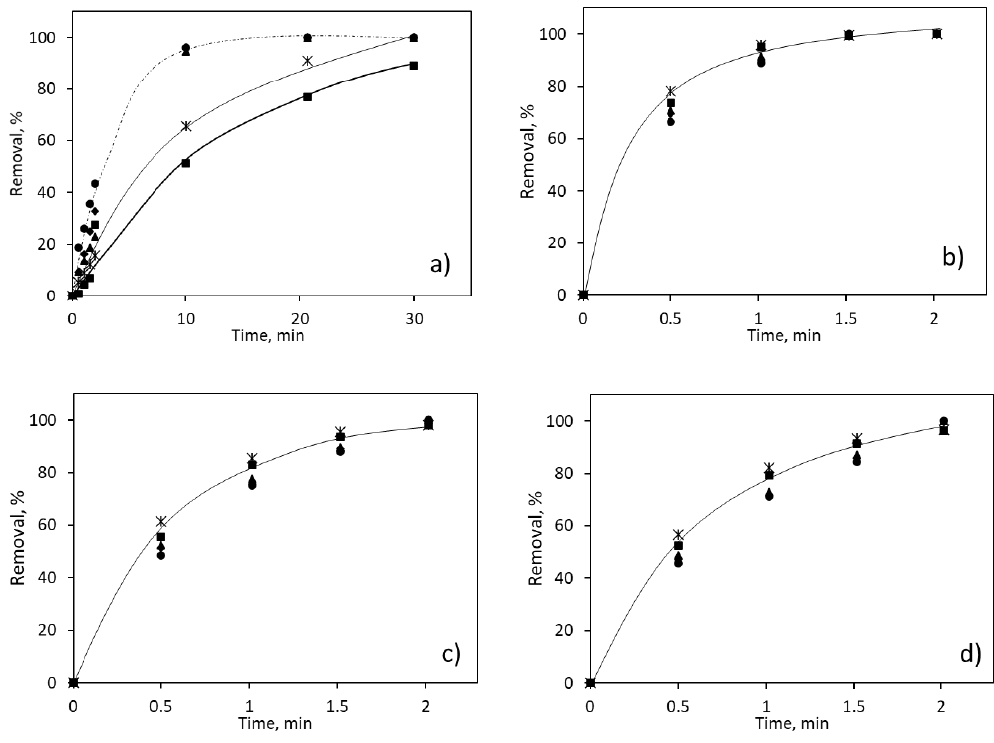
Figure 4. Influence of the H 2 O 2 addition on the removal of pollutants from the mixture: ( a ) caffeine; ( b ) thiamethoxam; ( c ) clothianidin; ( d ) imidacloprid. H 2 O 2 concentration: ■ — 5 mg dm −3 ; * — 10 mg dm −3 ; ▲ — 15 mg dm −3 ; ♦ — 30 mg dm −3 ; ●— 60 mg dm −3 . Table 1. Values of direct and indirect photolysis rate constants obtained and correlation coefficients (R 2 ) for the time-based pseudo-first-order kinetics for the degradation of the target pollutants. DP: Direct Photolysis. Pollutant Caffeine